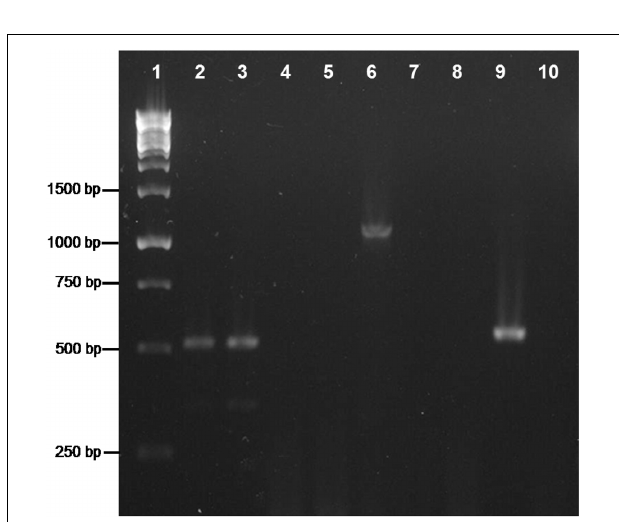
section showing a compact bacteriome. (E) Amplification of the region indicated in the dashed square in (D) to show the endosymbiotic system in more detail. Scale: 100 μ m.